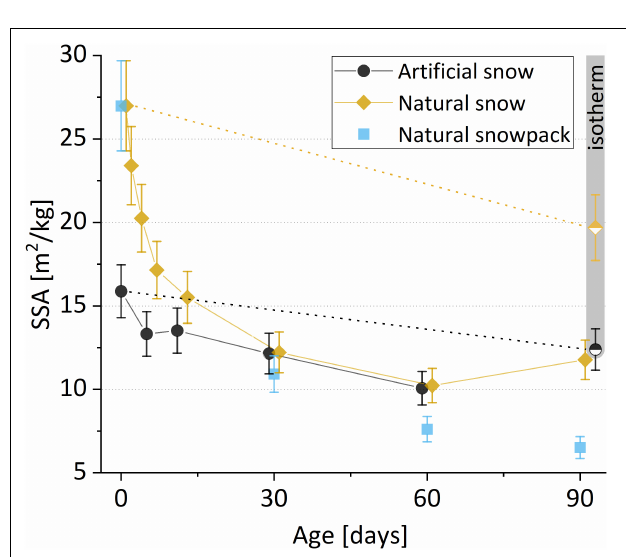
FIGURE 4 | Specific surface area evolution of natural (yellow diamonds) and artificial snow (black dots) aged at the artificial temperature gradient of 40 K/m and after 90 days isothermal storage at –20 ◦ C (gray bar, half-filled symbols); the blue squares represent SSA changes in 0-, 30-, 60-, and 90-day old snow from different depths of the snow pit at WFJ. These 4 samples originate from 4 different snowfall events at different stages in natural